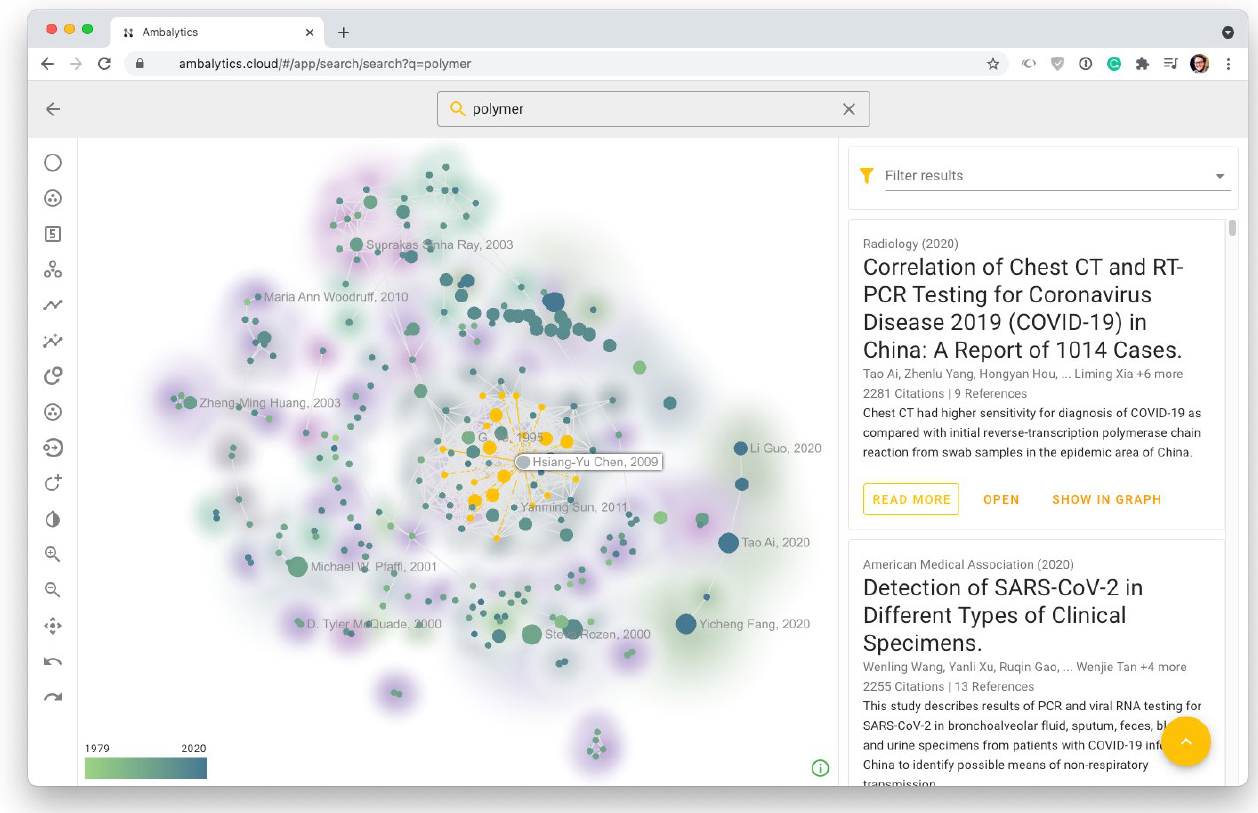
Figure 14. Search results page with graph